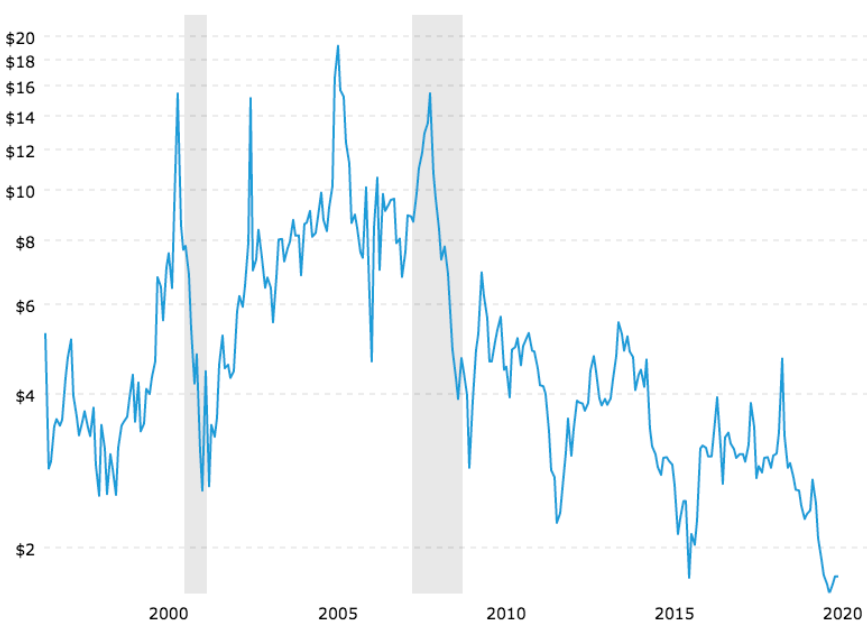
Figure 12. US Natural Gas Prices—Historical Chart, Macrotrends [89].